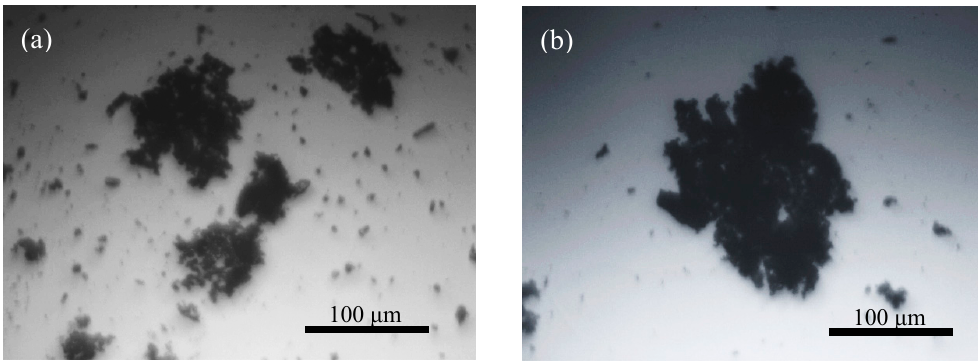
Figure 6. Optical microscopy images of the malachite aggregates ( a ) with the addition of kerosene emulsion; ( b ) with addition of 0.05 wt % octyl hydroxamate treated kerosene emulsion.